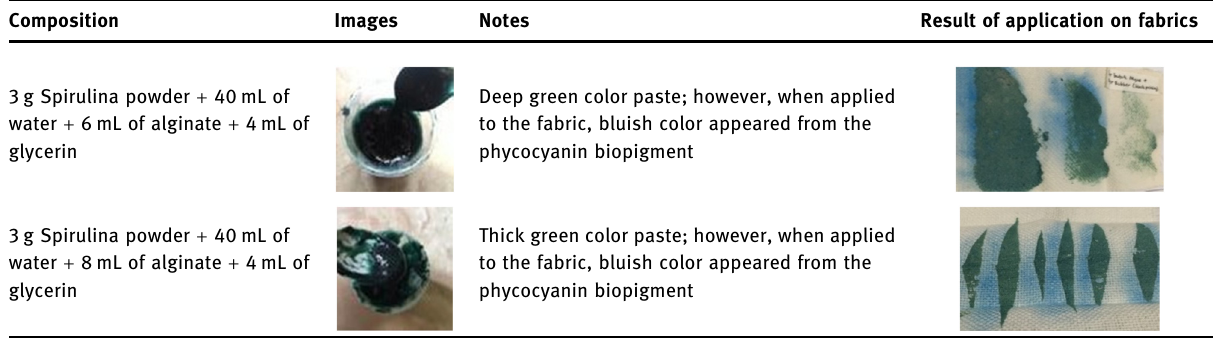
Table 5: Concentration variable of selected Spirulina platensis color paste Composition